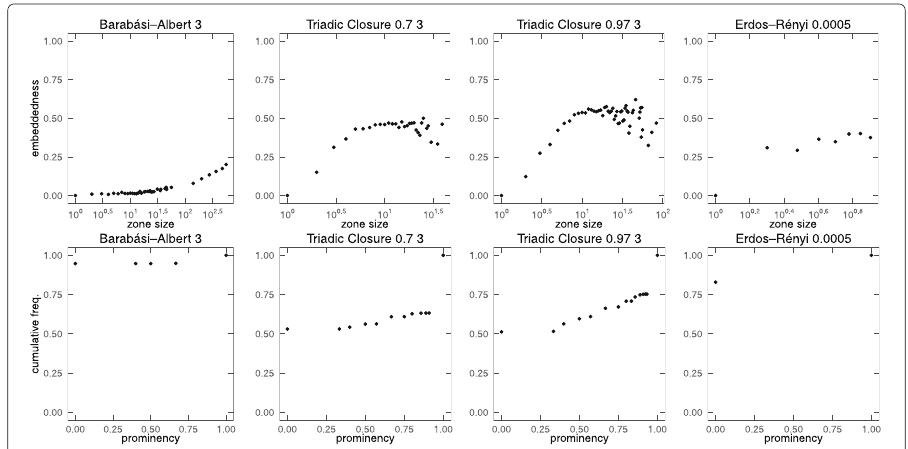
Fig. 10 Embeddedness and prominency in generated networks. The average embeddedness in relation to the size of the zone is shown in the upper row of plots. In the ER networks, there are only very small zones (up to ten nodes), with the average zone embeddedness increasing with the size of the zone and the maximum being around 0.4. A similar behavior is seen in the BA network with the modularity of 0.380, where the maximum average zone embeddedness is only around 0.2. The TC networks show a growing trend of the average embeddedness value up to the zone size being around 10 nodes; then the trend is rather reversed. However, the zone embeddedness value is higher than for the ER and BA networks, which is also associated with high modularity (see Table 6). At its peak, the average value of the zone embeddedness exceeds 0.5 or 0.6 for networks with the parameters 0.7 3 or 0.97 3 and with the modularity of 0.675 or 0.899. The occurrence of nodes with a given prominency in generated networks is shown in the lower row of cumulative distributions. In ER and BA networks, which are weakly dependent, nodes with a prominency value of